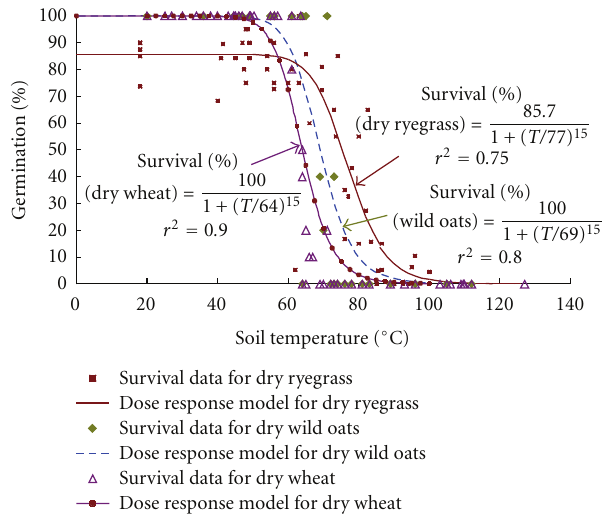
Figure 16: Dose-response curve for soil temperature versus seed survival percentage for wheat, wild oats, and perennial ryegrass seeds in dry sandy soil [24,